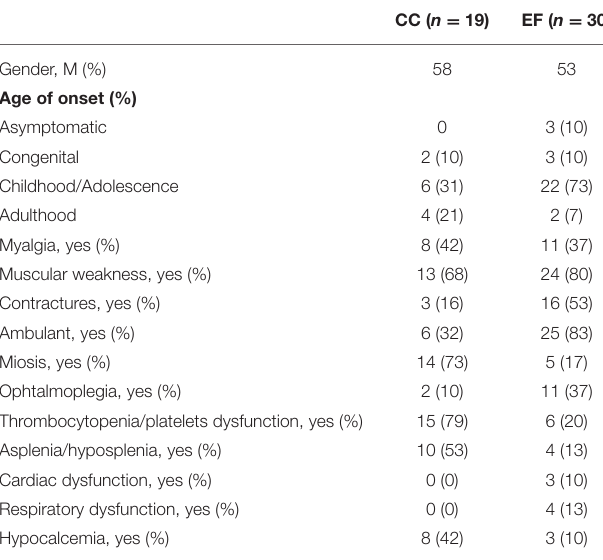
TABLE 2 | Clinical features of STIM1 mutations CC and EF.